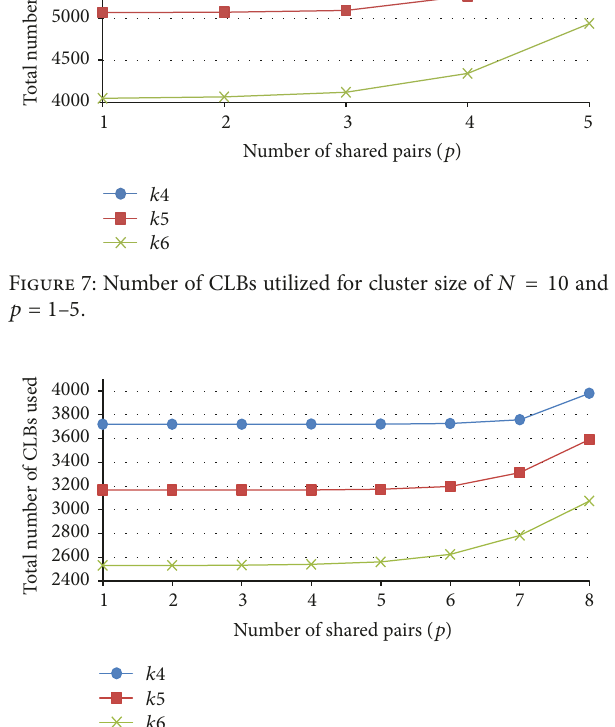
Figure 6: Comparison of the clustering methods for 𝑁 = 16 .